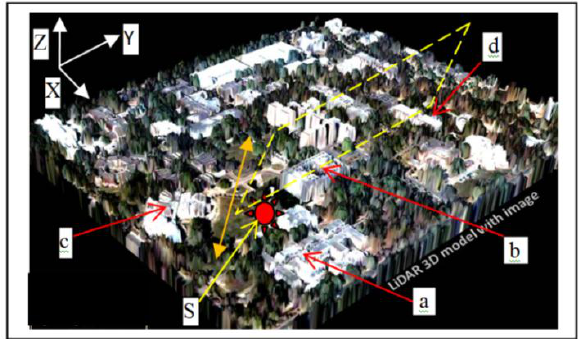
Figure 13 LIDAR 3D model of IIT Kanpur academic area. a, b, c, d are positions of buildings and S the position of sound source. Double sided yellow arrow indicates major unobstructed propagation